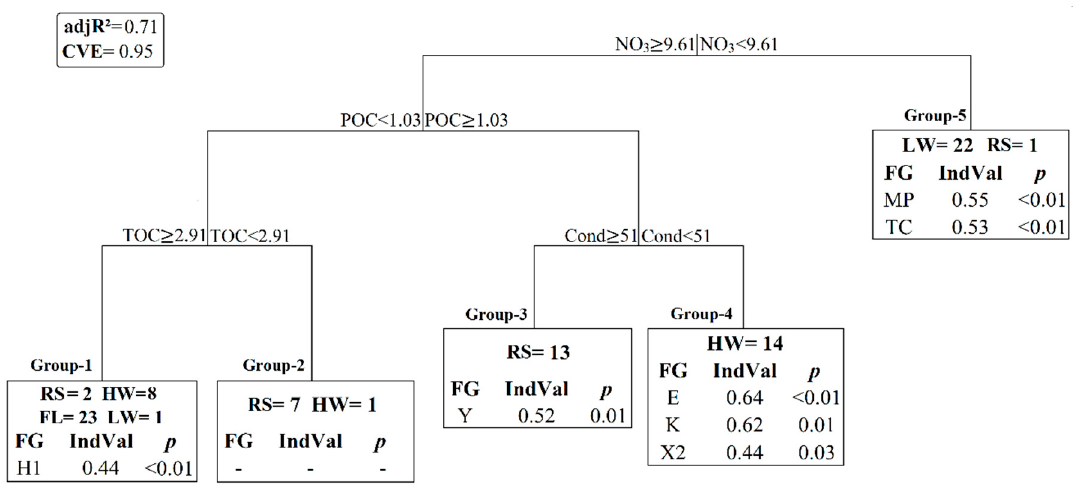
Figure 4. Multiple Regression Tree (MRT) map. Rising period (RS), high-water period (HW), flushing period (FL), low-water period (LW), species indicator value (Ind-Val), significance ( p ), adjusted R 2 (R 2 ), cross-validation error (CVRE). Groups 1 to 5 MRT clusters results.